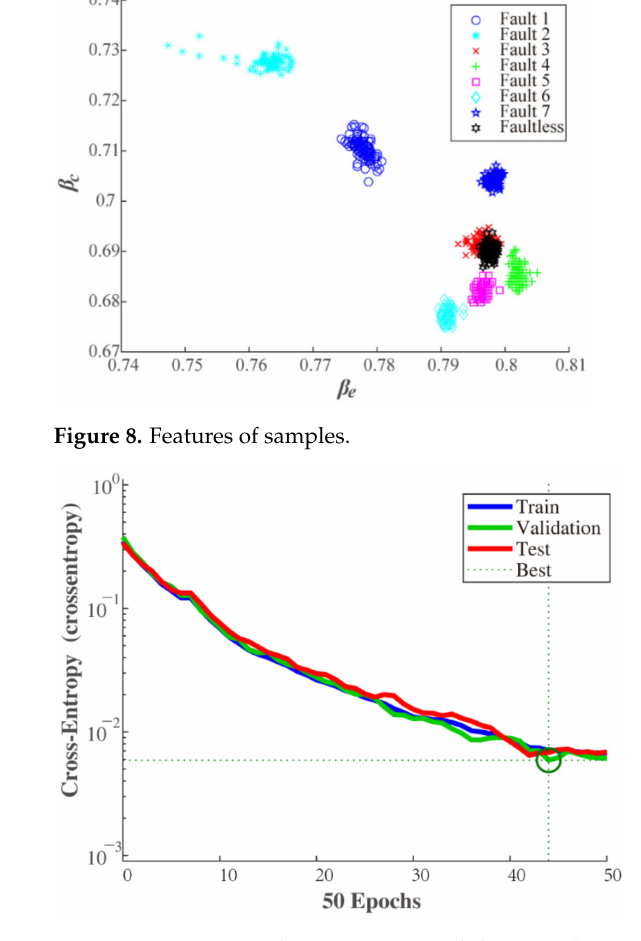
Figure 9. Loss curves during training, validation and